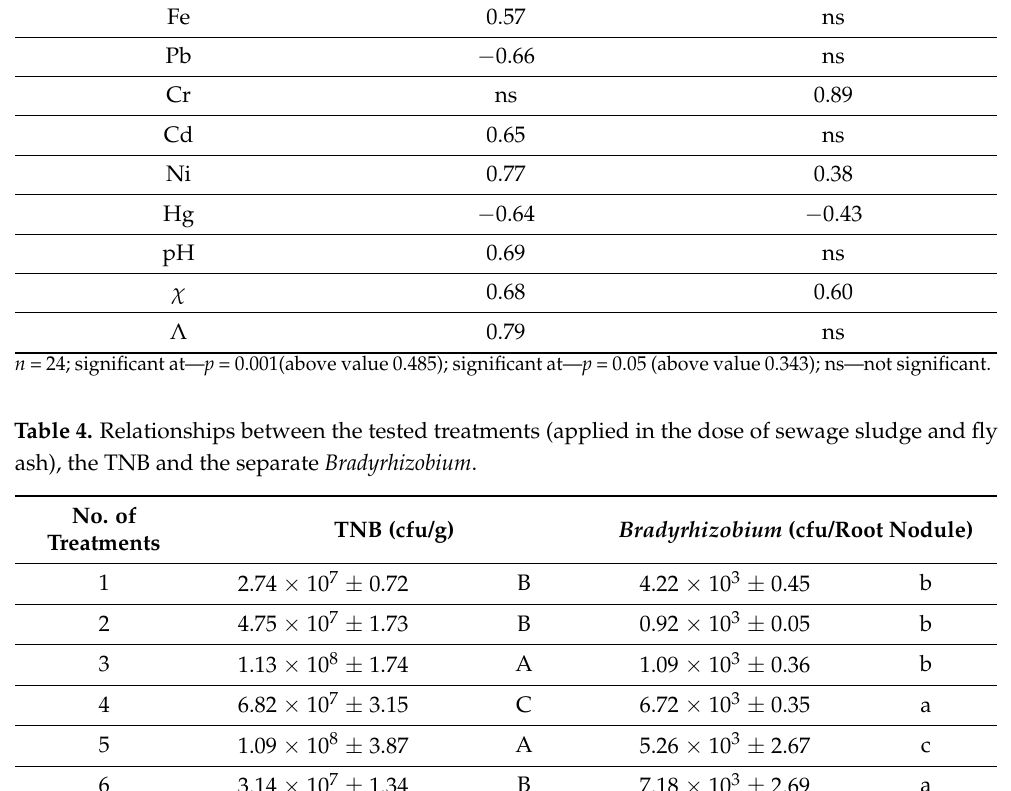
Table 3. Correlation between the growth of TNB, (cfu/g) Bradyrhizobium (cfu/nodule) and Fe (%) and other heavy metals ’ (mg·kg − 1 ) concentrations.